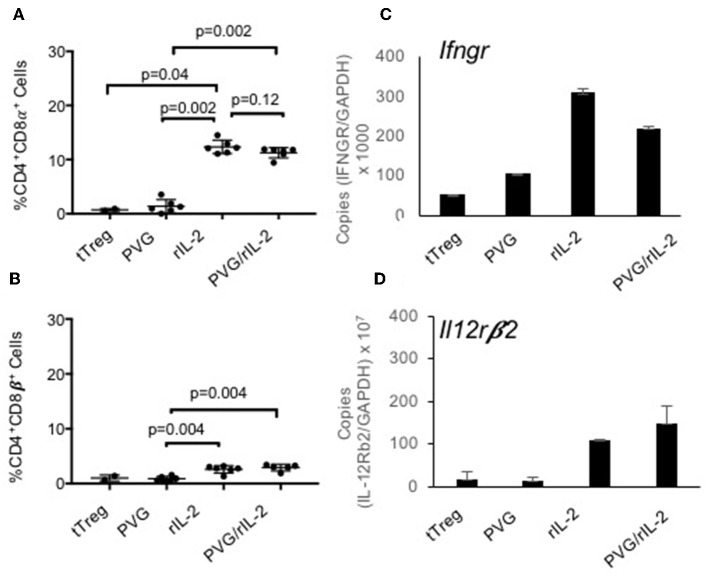
Examination of the effects of culture of naïve CD4+CD8−CD25+Treg with rIL-2 alone to culture with rIL-2 and alloantigen. To examine if the effects of culture were due to rIL-2 or alloantigen, we compared the phenotype of Treg after culture with rIL-2 alone, PVG alloantigen alone to that after culture with both rIL-2 and PVG alloantigen. Cultures for 4 days were carried out as described in Figure 1. (A,B) Staining for CD8α and CD8β was as for Figure 1. Culture of fresh tTreg with rIL-2 and no alloantigen also induced CD8α expression similar to when tTreg were cultured with rIL-2 and alloantigen. Again, no CD8α was induced by culture with PVG in the absence of rIL-2. There was a modest induction of CD8β with both rIL-2 and a combination of rIL2 and alloantigen stimulation. Data from two separate experiments and P values were calculated using a student t-test. (C,D) RT-PCR of tTreg after culture with rIL-2, PVG alloantigen and both rIL-2 and PVG alloantigen showed induction of mRNA for ifngr and Il12b2 in both tTreg cells cultured with rIL-2 alone and in tTreg cells cultured with both rIL-2 and PVG alloantigen, but not in tTreg cultured with no rIL-2 and PVG alloantigen.